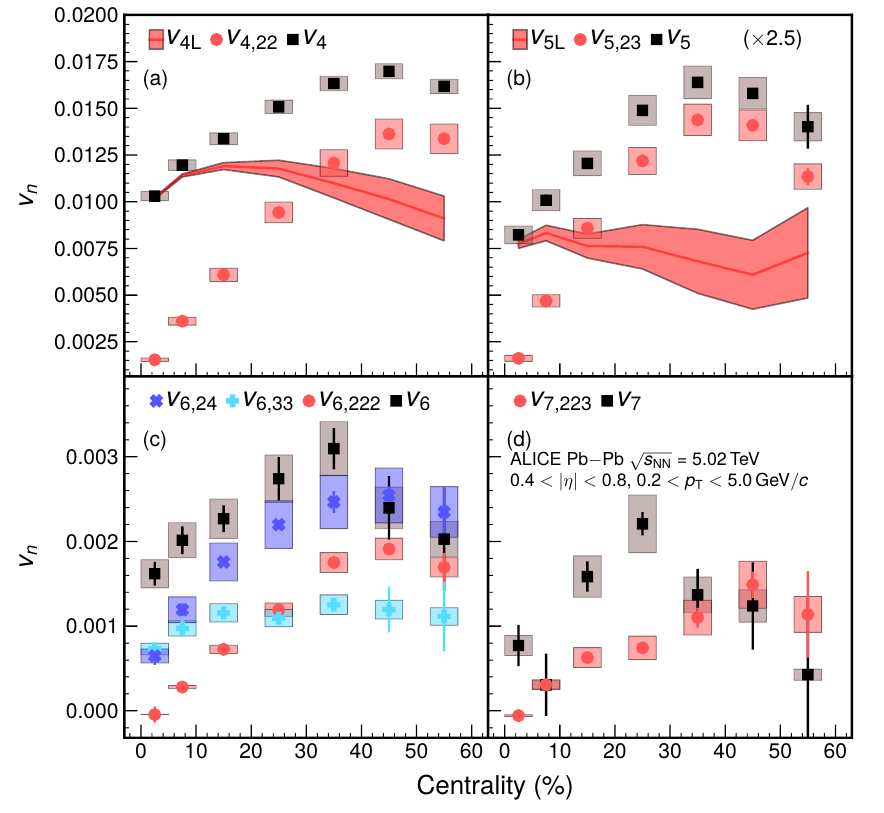
Figure 4 . Linear and non-linear (cid:13)ow modes as a function of centrality. The total contribution measured in Pb-Pb collisions at p s NN = 5 : 02 TeV is shown as black squares. Various non-linear contributions are presented in di(cid:11)erent red and blue colors, while the linear part, extracted from the aforementioned contributions, is shown as a red band. For panel (b), the data points are scaled by 2.5 for better visibility across the